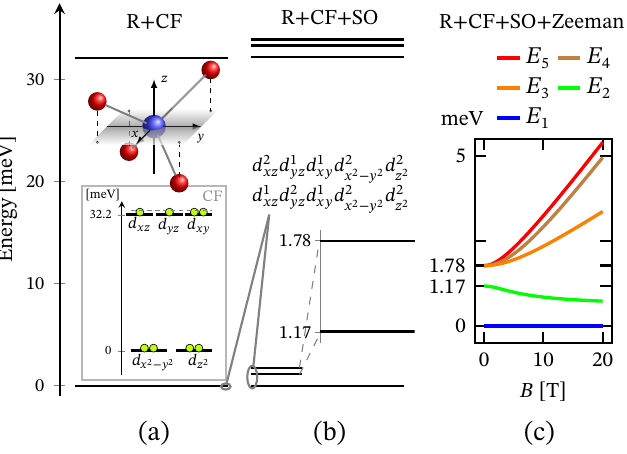
Figure 11. Low-lying energy level structure in the case of tetrahedral geometry. The values of the relevant parameters are given in Section 2.1. ( a ) Shows the splitting resulting from the effect of CF within the action of all repulsive Coulomb interactions. CF d -orbital splitting is illustrated in the inset, with electrons given as circles. The dashed line reminds that the considered configuration, with d xy core orbital, is one of the three possible. ( b ) Depicts the effect of spin–orbit interactions. ( c ) Presents the splitting of the low-lying energy levels resulting from the action of external magnetic field pointing along the z axis of the inner reference